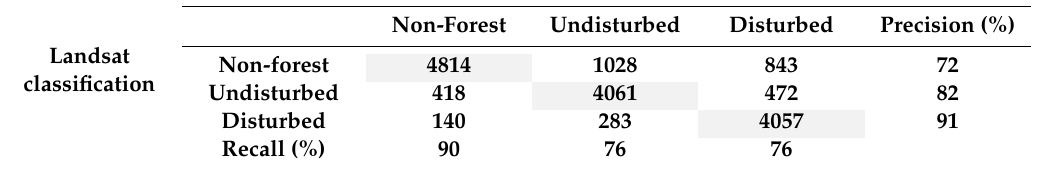
Table A3. Confusion matrix describing Landsat classification accuracy of the Elk City, ID study area for aggregated high-resolution pixels that were > 50% pure. Overall classification accuracy was 80% (n = 16,116